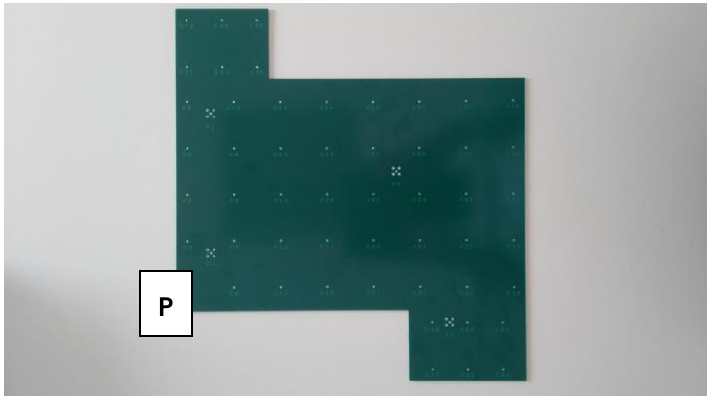
Figure 14. Manufactured power distribution network (PDN) board with the location of the measurement port P and the grid of possible positions of the decaps.